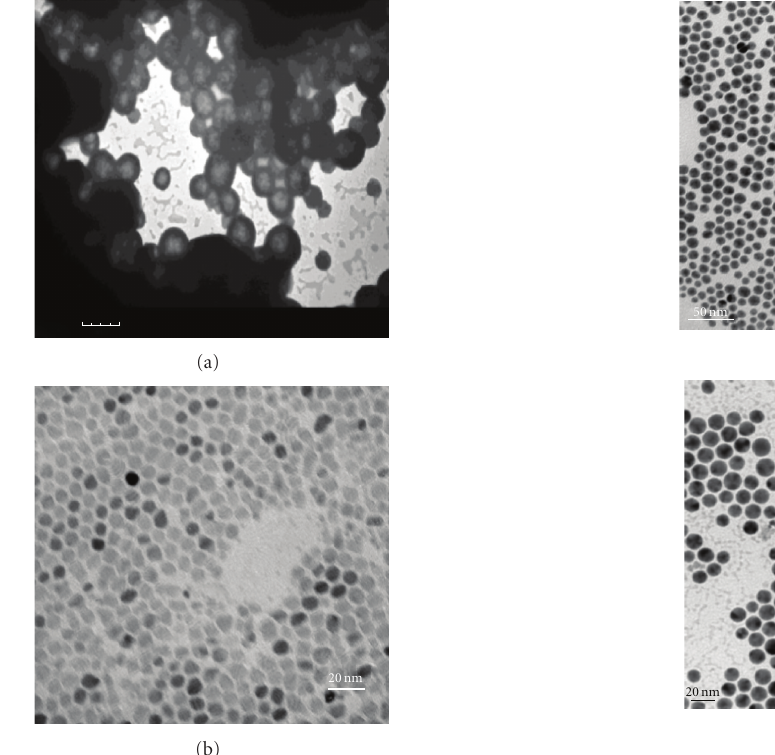
Figure 2: (a, b) TEM image of the prepared magnetite nanopar- ticles capped with ascorbic acid shows that these particles have spherical shape with average size of 8 . 0 ± 2 . 0nm.